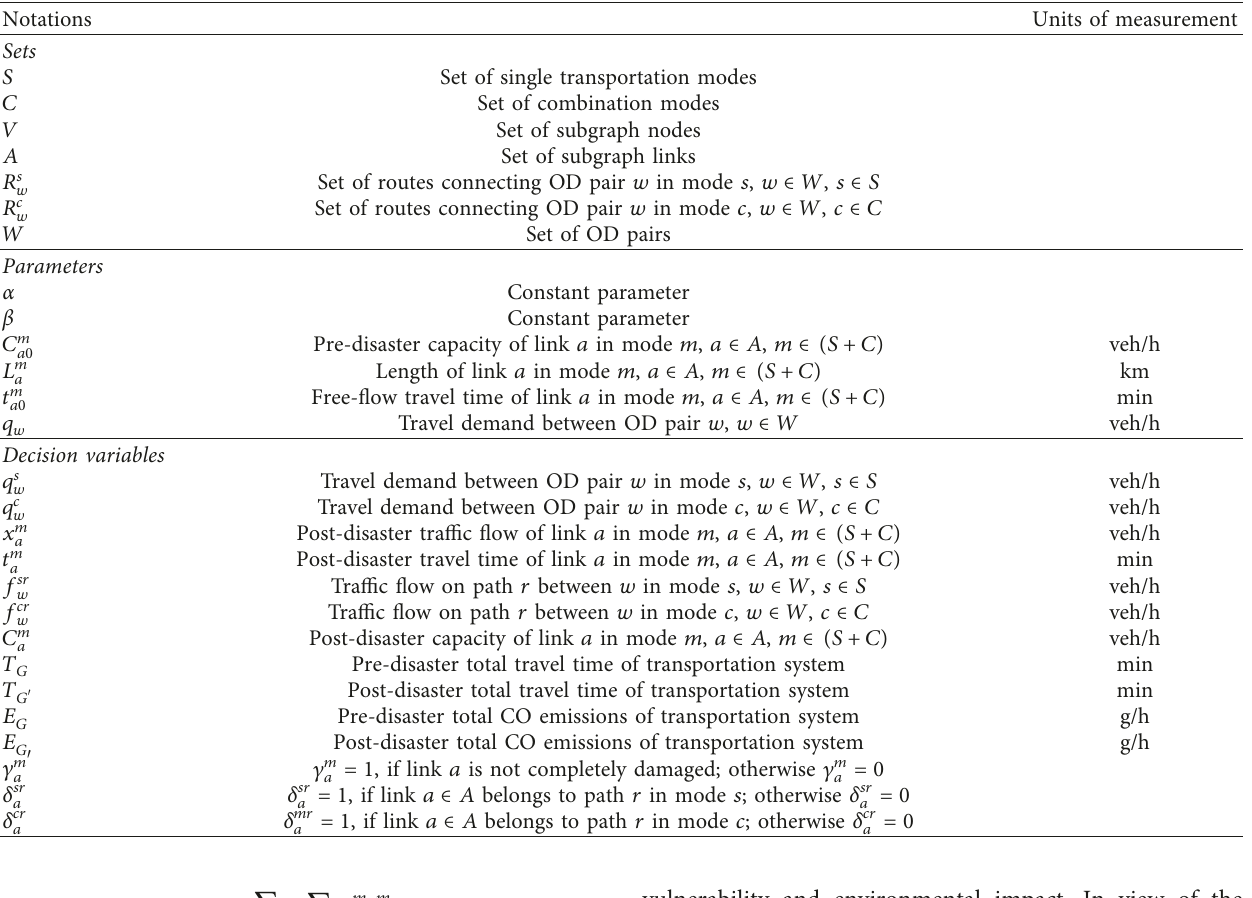
Table 3: Sets, parameters, and decision